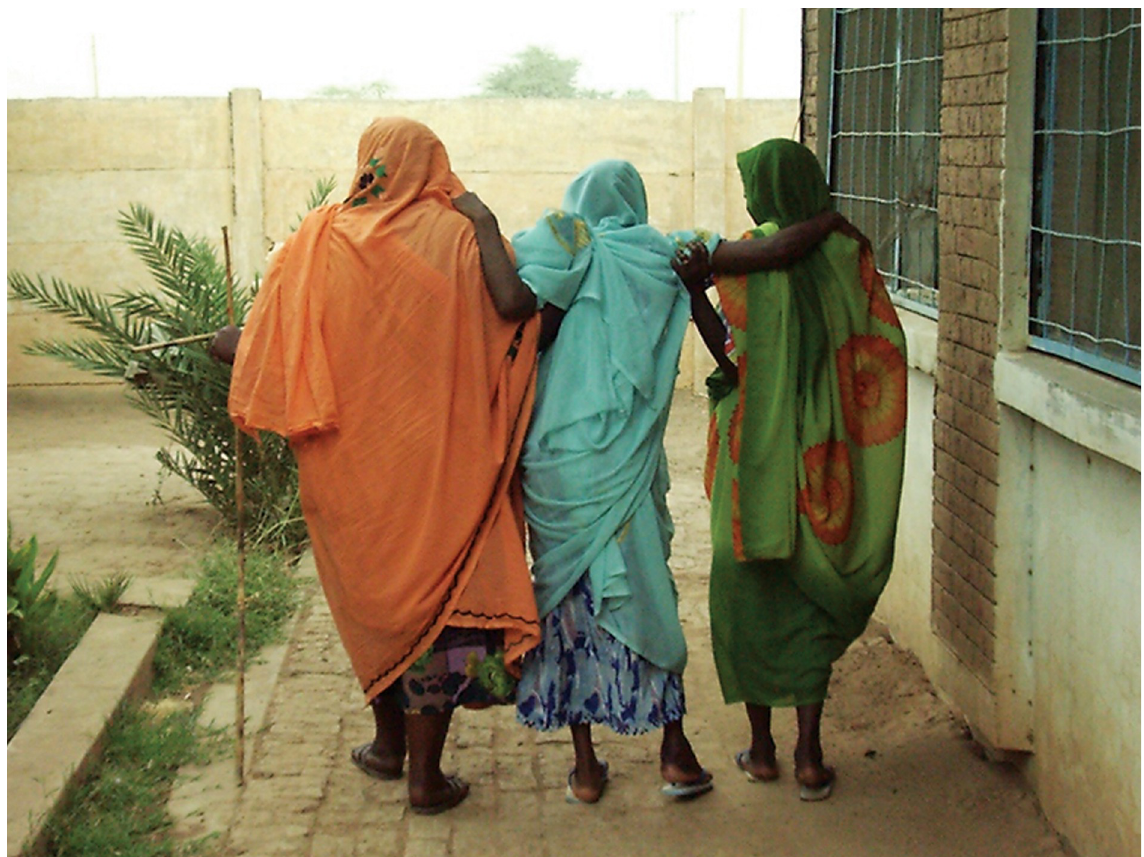
Fig 1. A lady with mycetoma supported by two family members to execute her normal live activities.